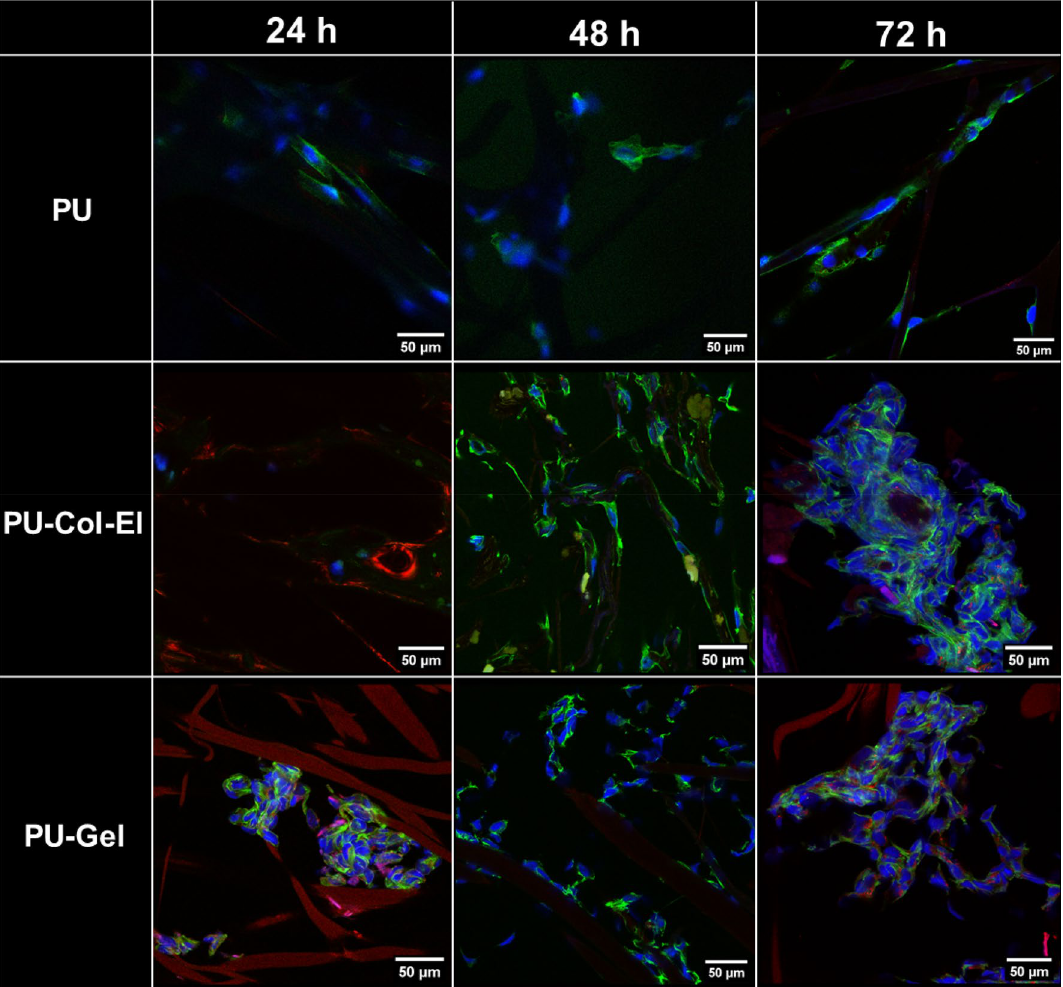
Figure 9. Fluorescent images of HUVECs on PU, PU-Col-El, and PU-Gel scaffolds obtained using confocal microscopy. The green color corresponds to the cytoplasm, blue to the cell nuclei, and red to the scaffold fibers (on PU-Col-El and PU-Gel Flow cytometry analysis indicated good cytocompatibility of scaffolds with endothelial cells, since the scaf- folds did not trigger apoptosis and were not cytotoxic. The blended scaffolds (PU-Gel and PU-Col-El) had better cytocompatibility than the PU scaffold. A reduction in cell proliferation compared to that of the control was also observed for the PU scaffolds. The MTT assay results in our previous studies 17,18 agree with these findings, confirming that HUVEC viability significantly decreased (p > 0.05) after 48 h compared to that of the control, PU- Col-El, and PU-Gel scaffolds (Supplementary Fig. S1 online). Based on previous studies, the addition of Col and El is expected to yield the best cytocompatibility profile 22,26 , yet cell viability and proliferation with the PU scaffold